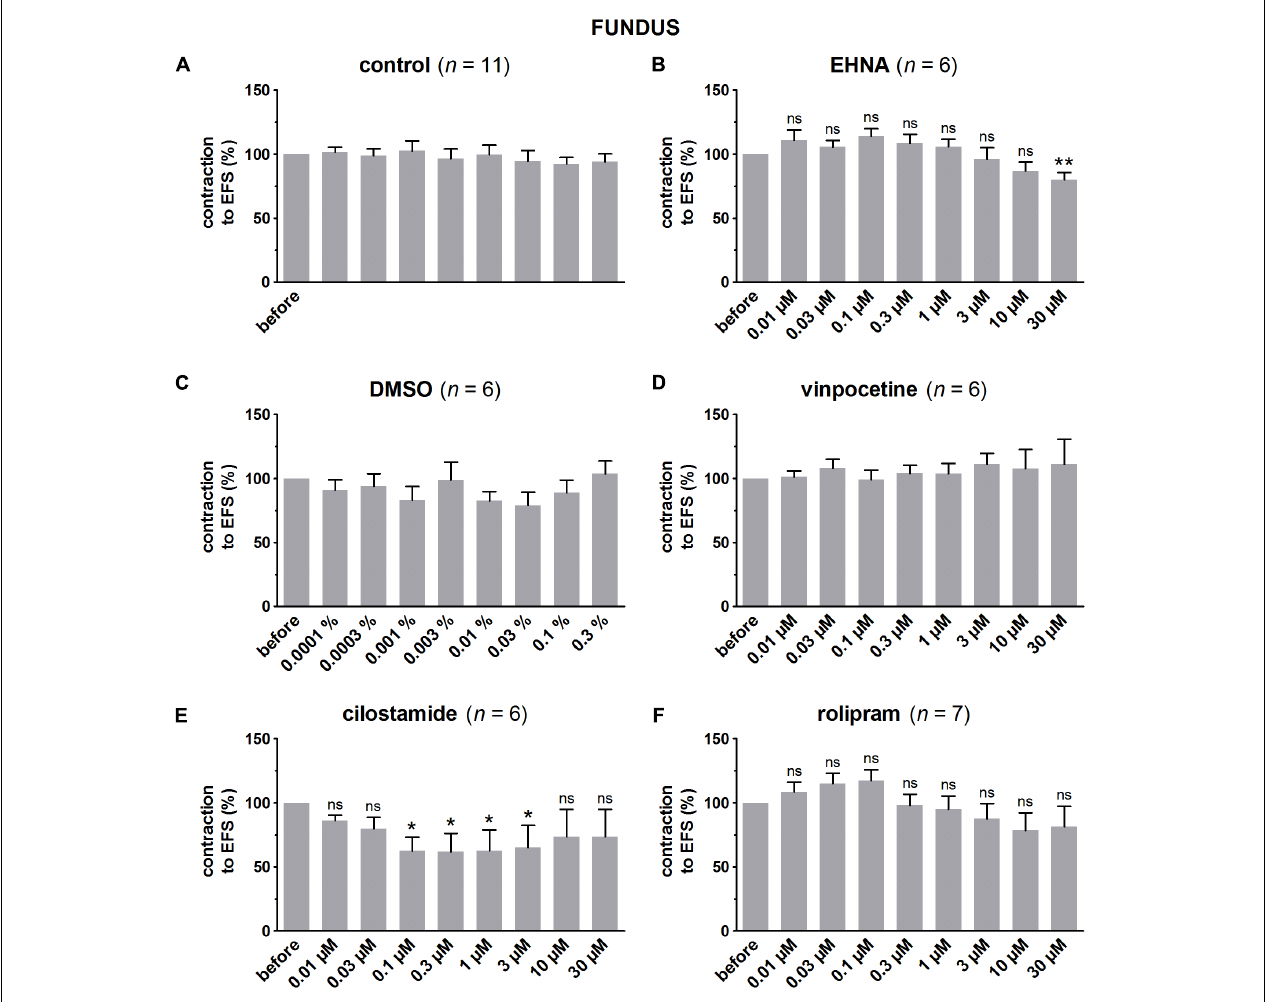
FIGURE 5 | Influence of increasing concentrations (0.01–30 µ M) of the PDE inhibitors EHNA (B) , vinpocetine (D) , cilostamide (E) and rolipram (F) , and the solvent DMSO (C) on submaximal electrically induced cholinergic contractions at V 50% (10 s trains at 4 Hz, 0.5 ms, interval of 5 min) in murine fundus circular smooth muscle strips. Parallel time controls not receiving PDE inhibitor or solvent are shown in (A) . Five contractions were induced in the presence of each concentration of the PDE inhibitor and every 5 th contraction is shown, expressed as percentage of the mean of the five contractions before addition of the PDE inhibitor. Experiments were performed in the continuous presence of 4 µ M guanethidine and 300 µ M L-NAME. Means ± SEM; ns not significant, ∗ P < 0.05, ∗∗ P < 0.01 versus reference before (repeated measures ANOVA with Bonferroni corrected t -test). For control, DMSO, and vinpocetine, the repeated measures ANOVA was not